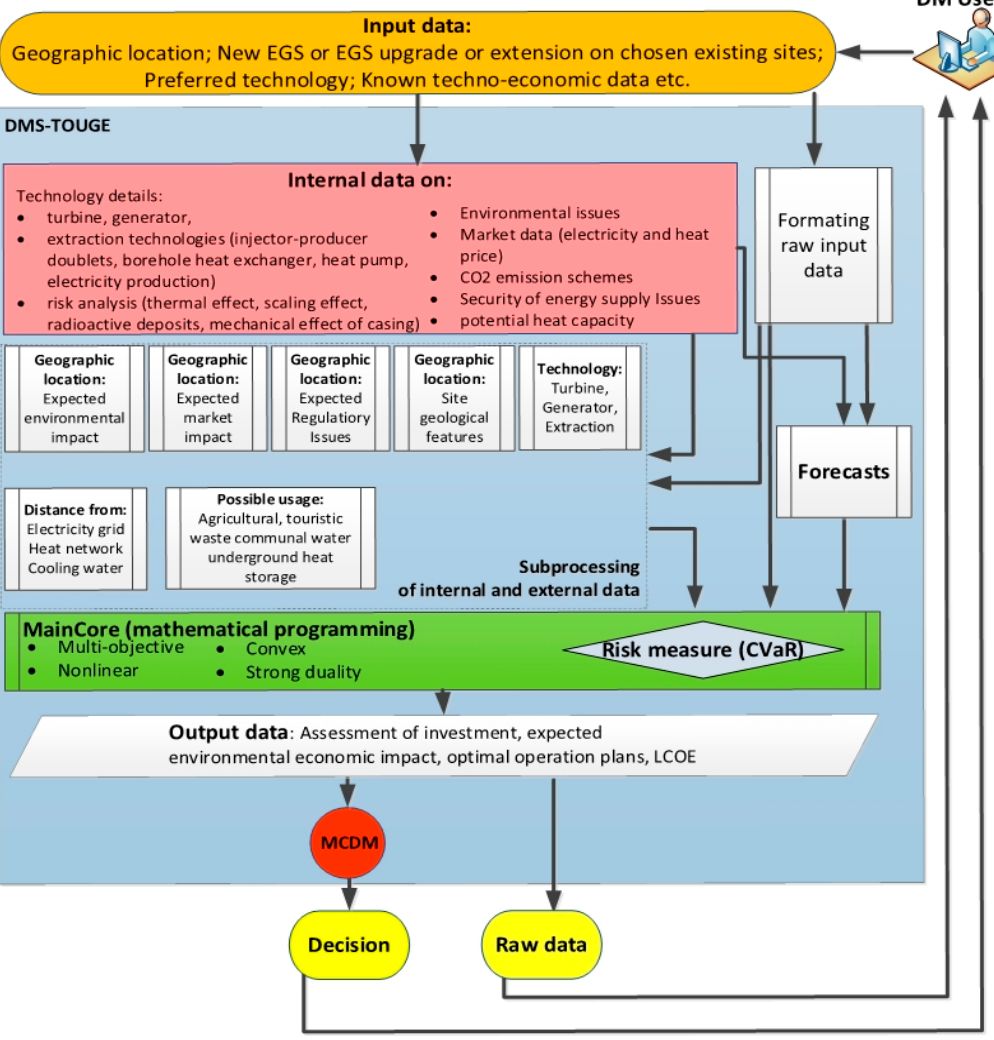
Figure 1. Schematic description of the main processes in Decision-Making Support Tool for Optimal Usage of Geothermal Energy (DMS-TOUGE).